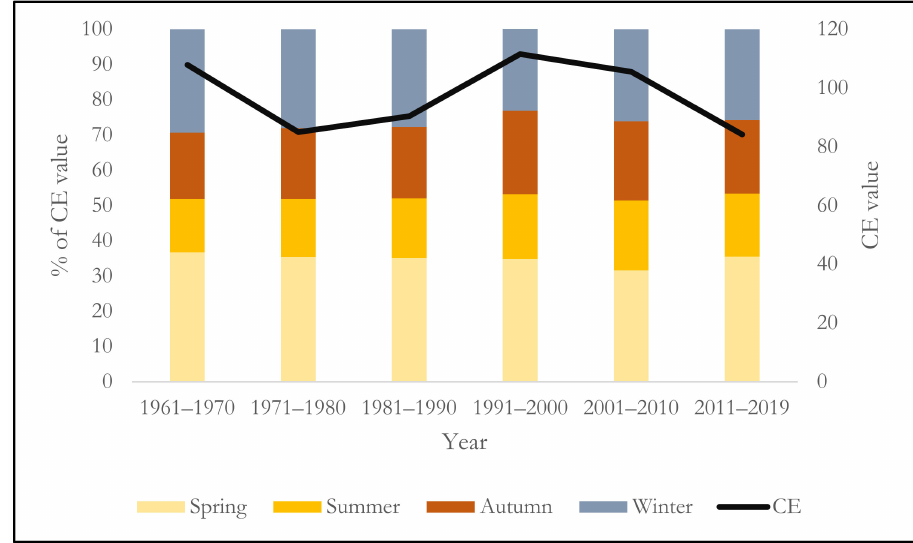
Figure 16. Changes in CEmean by season and decade during the study